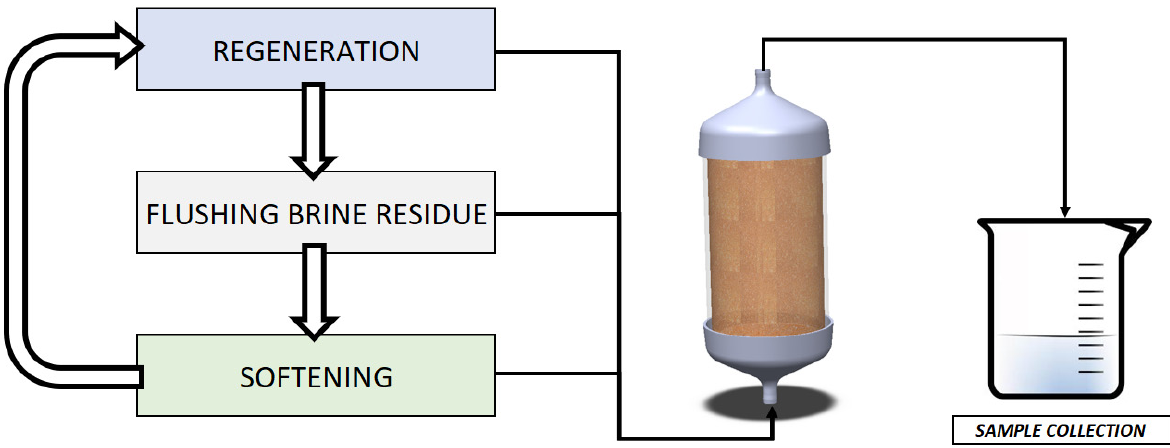
Figure 1. Test schematics with CAD representation of encapsulated resin.